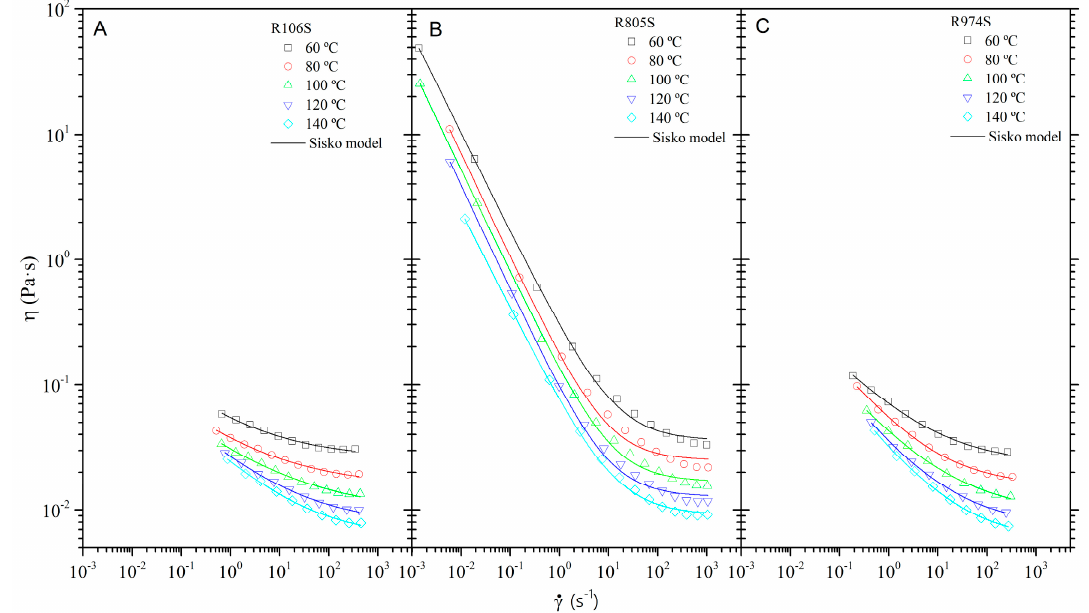
Figure 4. Flow curves of HFS suspensions as a function of shear-rate at different temperatures. ( A ) Suspension R106S. ( B ) Suspension R805S. ( C ) Suspension R974S. (Solid lines represent the Sisko model).